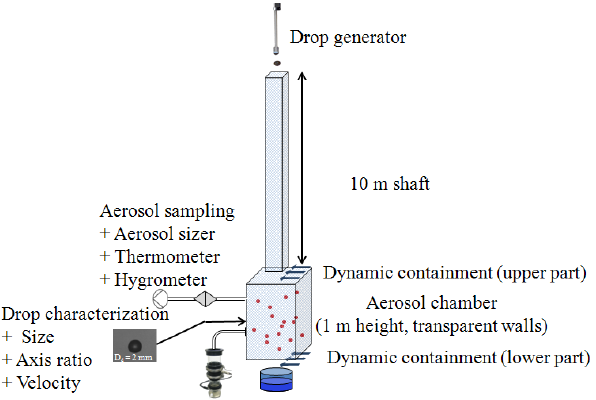
Figure 2. BERGAME Figure 1. BERGAME setup